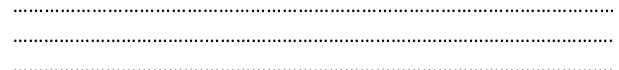
14. What is the mortality figure ( % )?